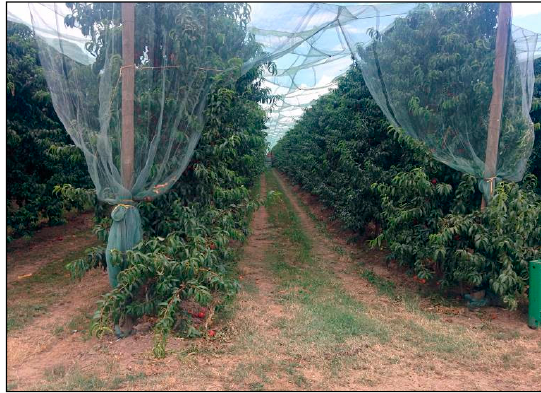
Figure 2. The peach orchard.